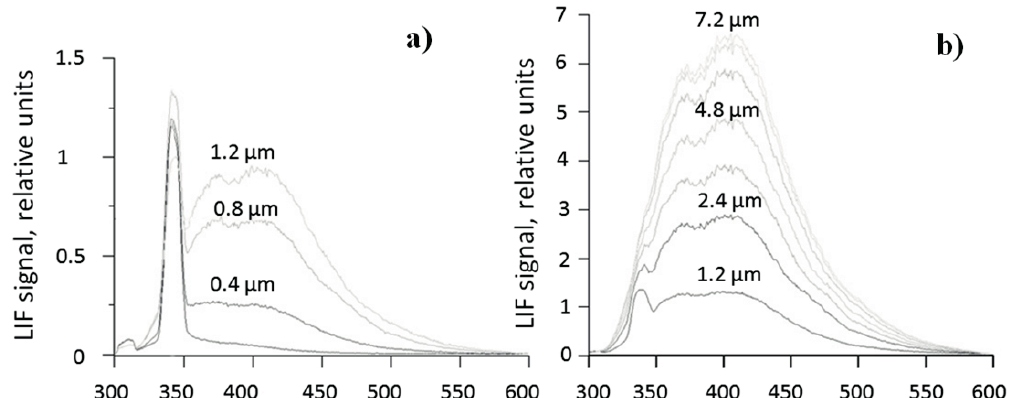
Fig. 7 LIF spectra of water with different oil film thickness: (a) 0 to 1.2 µm; and (b) 1.2 to 7.2